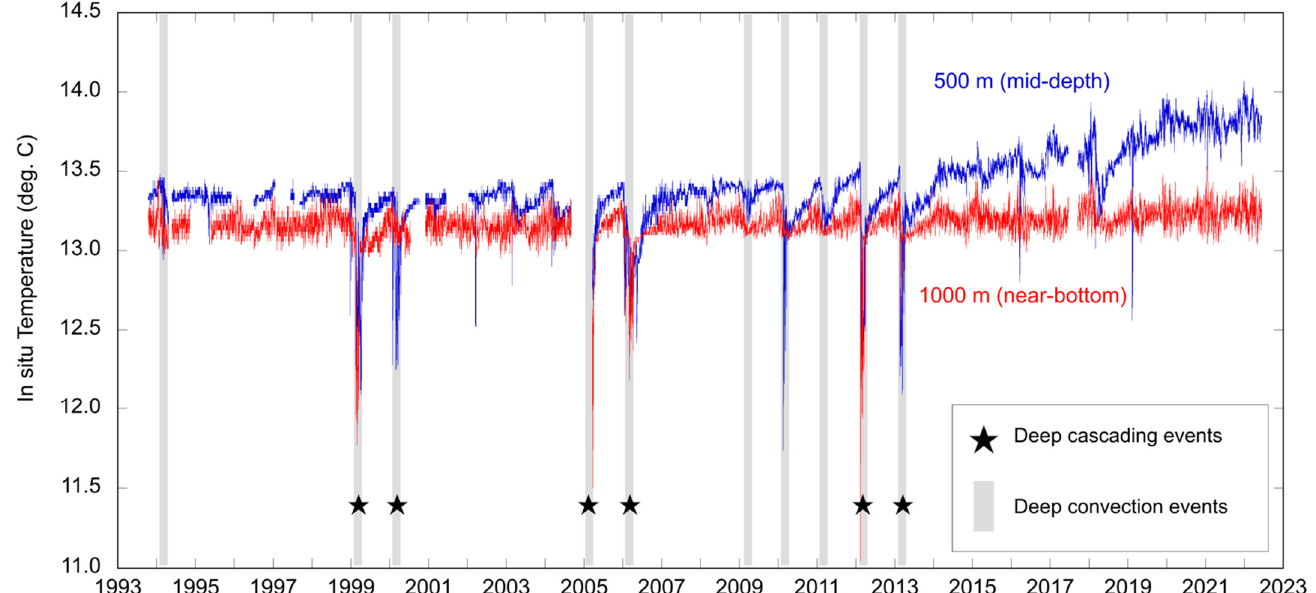
Figure 8. Temperature time series measured between October 1993 and June 2022 at 500 m and 1000 m depth in the Lacaze-Duthiers Canyon. Deep cascading events (after [22,24–26]) are indicated by black stars and deep convection events (after [43,45,46,51]) are indicated by grey bands.